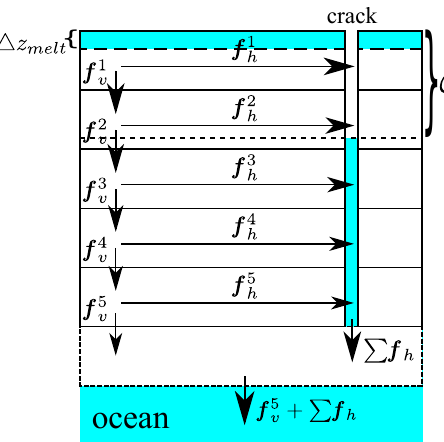
Figure 5. Brine fluxes of the complex flushing parametrization re- sulting from meltwater formation at the surface as described in Sect. 2.4.2. The horizontal fluxes f h transport heat and salt to the lowest layer directly via cracks in the ice, while the vertical fluxes f v advect heat and salt from layer to layer. ζ is the freeboard of the ice and (cid:52) z melt is the depth of the